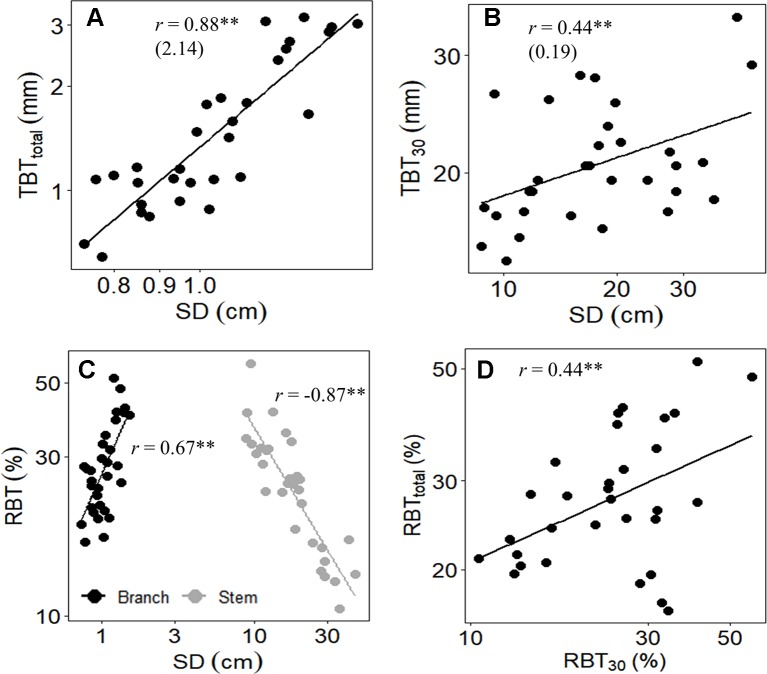
Relationships between (A) total bark thickness at 30 cm from the ground (TBT30) and the stem diameter (SD), (B) total bark thickness of branches (TBTtotal) and SD, (C) relative bark thickness of branches (RBTtotal, black circles) and main stem (RBT30, gray circles) with SD of both branches and stem, and (D) RBTtotal and RBT30 of 31 tree species from Brazilian Cerrado. Significance of Pearson correlation coefficients: *P ≤ 0.05; **P ≤ 0.01. In (A and B), the slopes of the regression lines are given in parentheses.